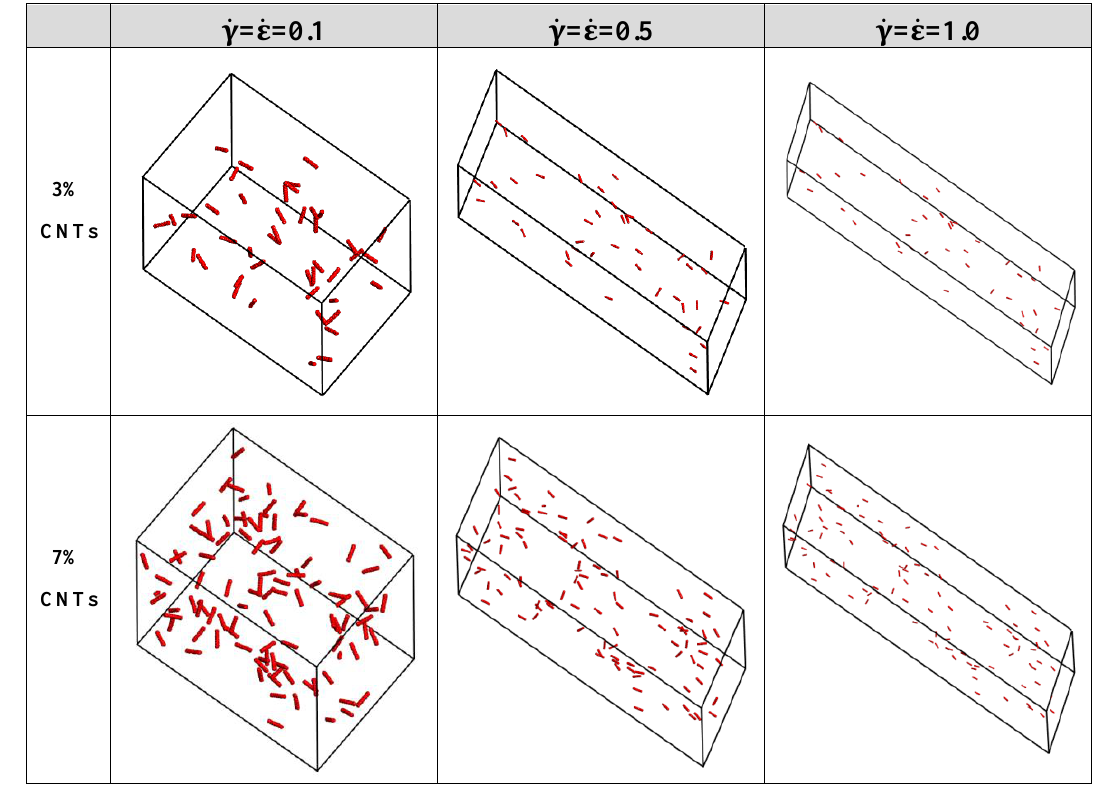
Figure 3. The structure of CNTs/UHMWPE composites at different CNTs mass fractions under a low, moderate, and high extensional-shear coupled rates (0.1, 0.5, and 1.0). The beads of PE are not displayed in this study and beads of CNTs are displayed in CPK style with CPK scale of 2.5 for clarity.